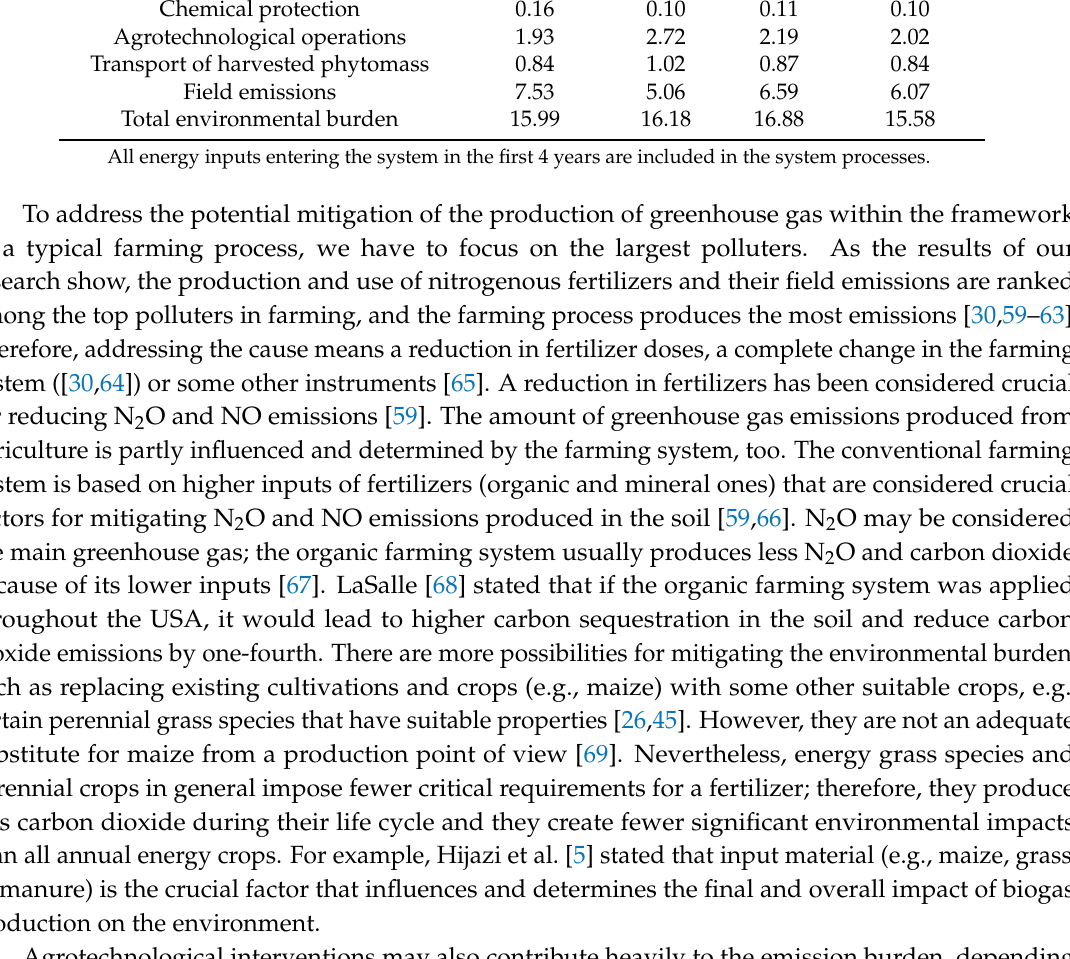
Table 18. Emission load (kg of CO 2 eq) according to the production unit (GJ). System Subprocesses Maize M × G RCG Sz-1 Organic fertilizers 0.29 0.17 x x Mineral fertilizers N 4.14 Mineral fertilizers